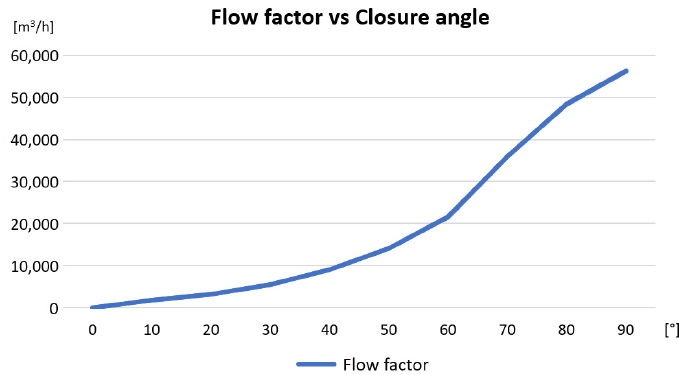
Figure 3. Flow factor according to closure angle for a DN500 ball valve.